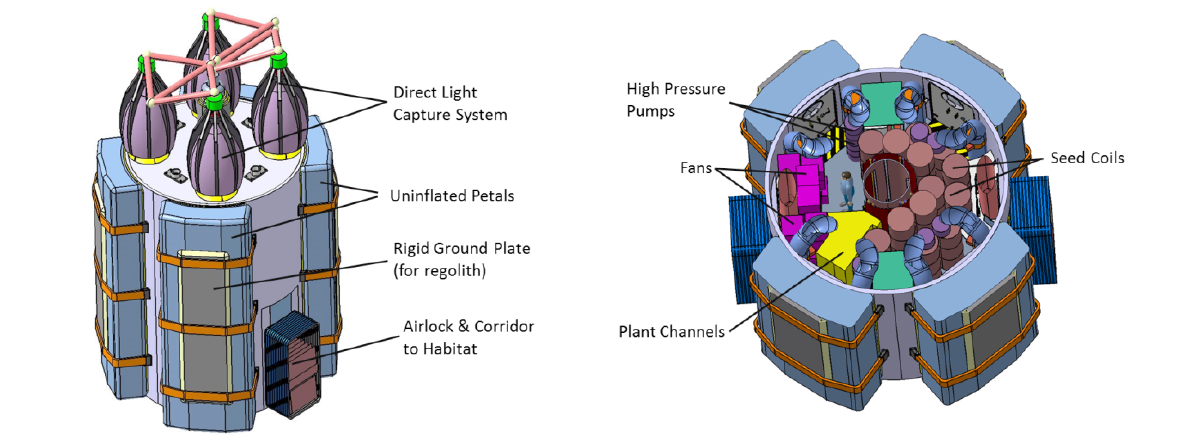
Figure 7: Left: Stowed GHM configuration. Right: Stowed configuration showing middle floor section cut as a representative example of the internal stowed configuration of the